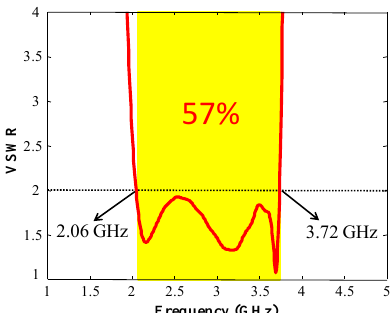
Figure 3: The simulated VSWR performance